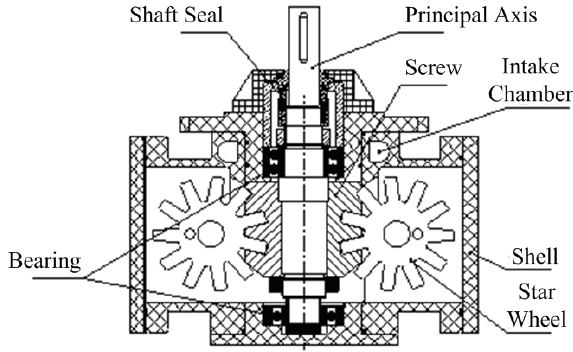
Figure 1. Four forms of single screw structure: ( a ) CP type; ( b ) CC type; ( c ) PP type; ( d ) PC type.